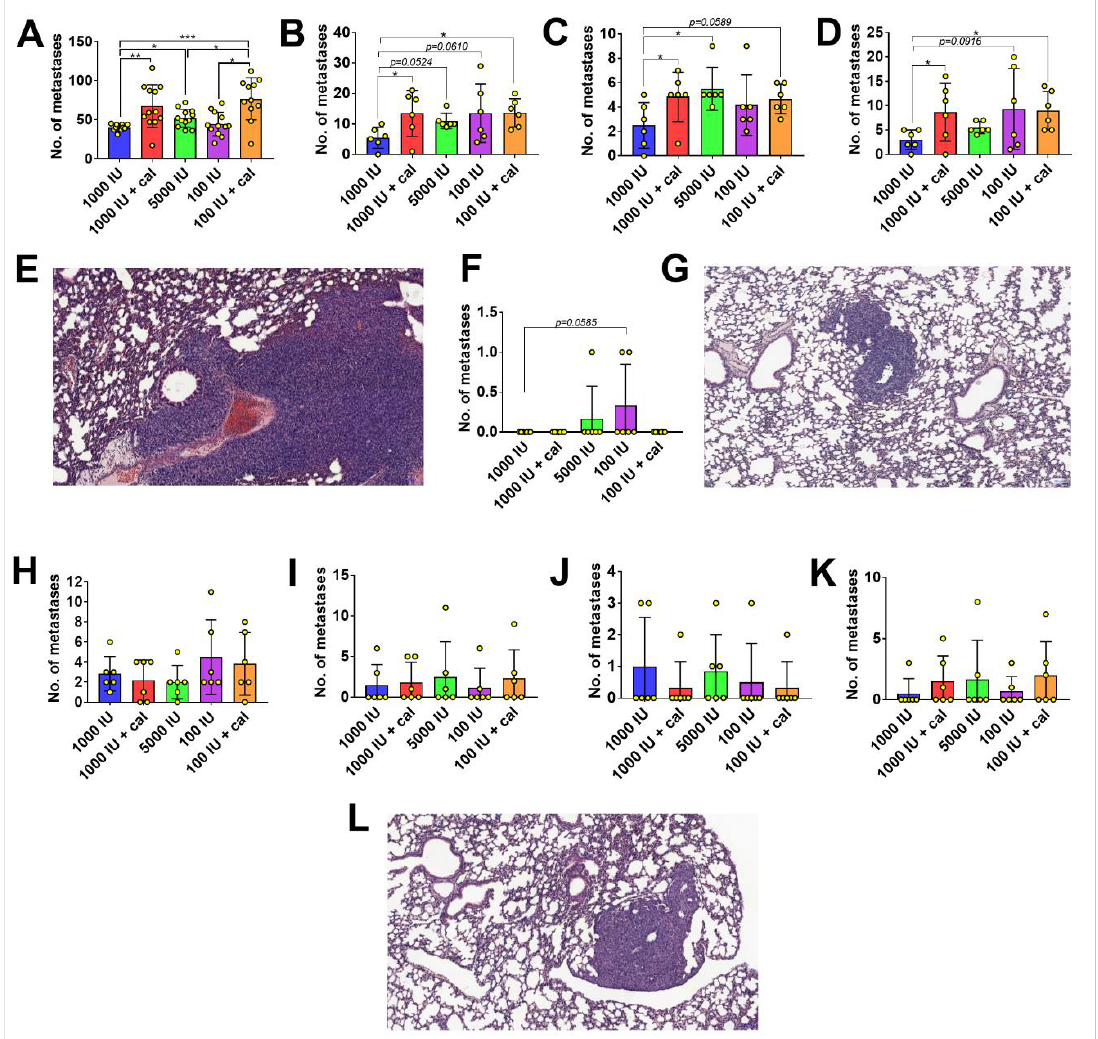
Figure 3. Macroscopic and histopathological analyses of lung metastases. ( A – E ) 4T1: ( A ) macroscopic count for metastases; ( B ) histopathological count for metastases—sum of large metastatic foci and disseminated metastases; ( C ) no. of histologically determined large metastatic foci; ( D ) no. of disseminated metastases; ( E ) representative hematoxylin and eosin (H&E) staining of the lungs from 4T1 tumor-bearing mice; magnification— × 100, scale bar—100 µ m. ( F , G ) 67NR: ( F ) histopathological analysis—single metastatic foci; ( G ) representative H&E staining of the lungs from 67NR tumor-bearing mice; magnification— × 100, scale bar—100 µ m. ( H – L ) E0771: ( H ) macroscopic count for metastases; ( I ) histopathological count for metastases—sum of large metastatic foci and disseminated metastases; ( J ) no. of histologically determined large metastatic foci; ( K ) no. of disseminated metastases; ( L ) representative H&E staining of the lungs from E0771 tumor-bearing mice; magnification—×100, scale bar—100 µm. Mean values and standard deviation with data for individual mice are presented. Statistical analysis: Dunn’s multiple comparisons test or ( A ) and ( H ) Sidak’s multiple comparisons test. * p < 0.05; ** p < 0.01; *** p < 0.001.